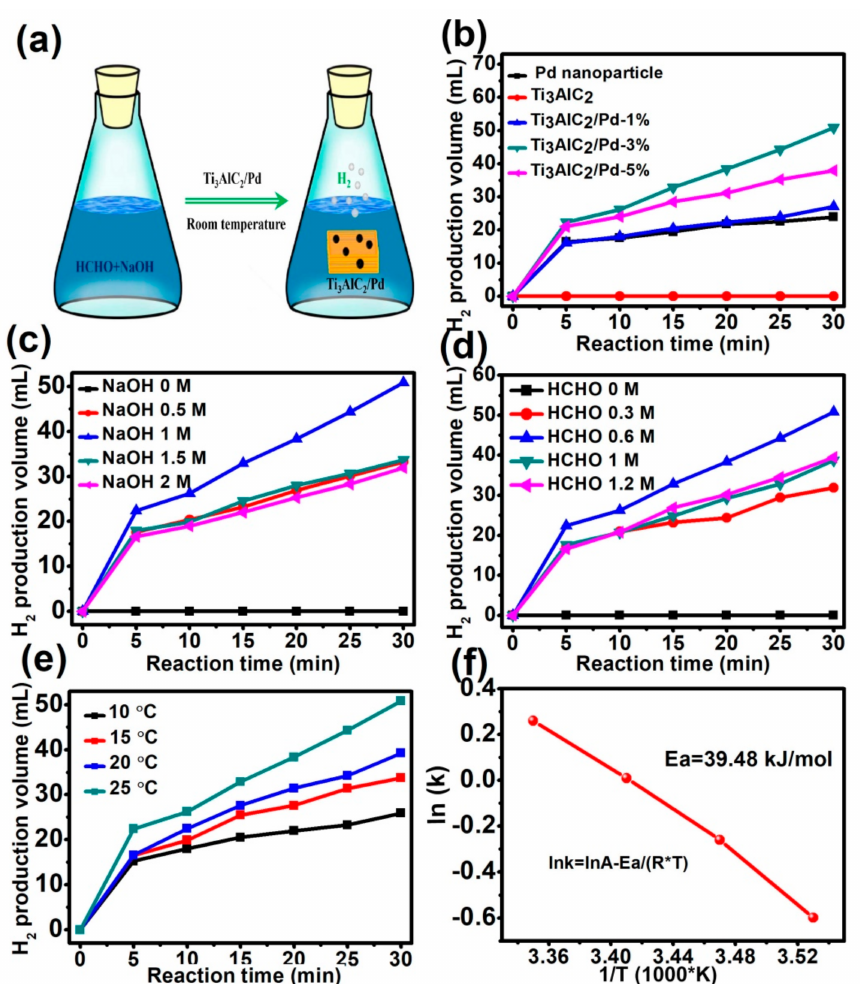
Figure 4. ( a ) Schematic illustration of the catalytic hydrogen production process over Ti 3 AlC 2 /Pd. ( b ) The comparison of hydrogen generation over different catalysts. Reaction condition: NaOH: 1 M, HCHO: 0.6 M, catalyst: 15 mg, reaction temperature: 25 ◦ C. ( c ) Effect of NaOH concentrations on the hydrogen production. Ti 3 AlC 2 /Pd-3% catalyst: 15 mg, HCHO: 0.6 M, temperature: 25 ◦ C; ( d ) effect of HCHO concentration on the hydrogen production. Ti 3 AlC 2 /Pd-3% catalyst: 15 mg, NaOH: 1 M, temperature: 25 ◦ C. ( e ) Effect of reaction temperature on the hydrogen production, Ti 3 AlC 2 /Pd-3% catalyst: 15 mg, NaOH concentration: 1 M, HCHO concentration: 0.6 M. ( f ) Arrhenius plots for the H 2 generation reaction over Ti 3 AlC 2 /Pd-3%